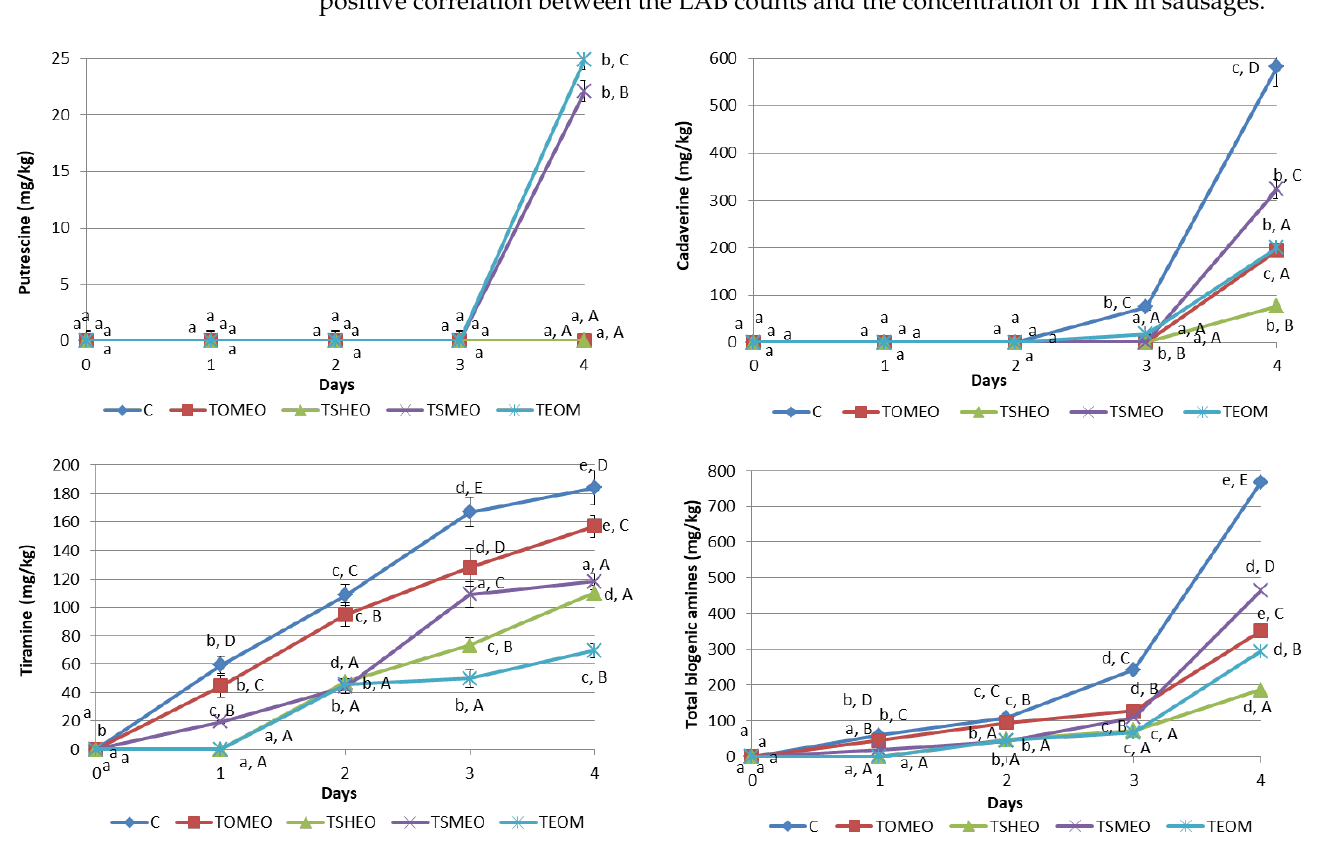
(24.9 mg/kg), after four days of refrigerated storage. Cadaverine (CAD) was determined